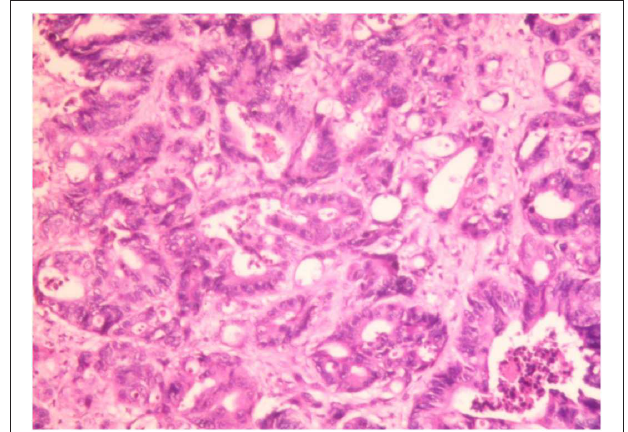
FIGURE 3 | Hepatic histopathology of a case of CRC patient. Accumulation of fat vacuoles (steatosis) and abnormal tumor cells were observed in hepatic lobules. Immunohistochemical result: CK7 (focal + ), CK20 (–), CDX2 ( + ), villin ( + ), Ki67 (about 60% + ), SATB2 ( + ), CDH17 ( + ). The liver metastasis was consistent with the origin of colorectal adenocarcinoma.